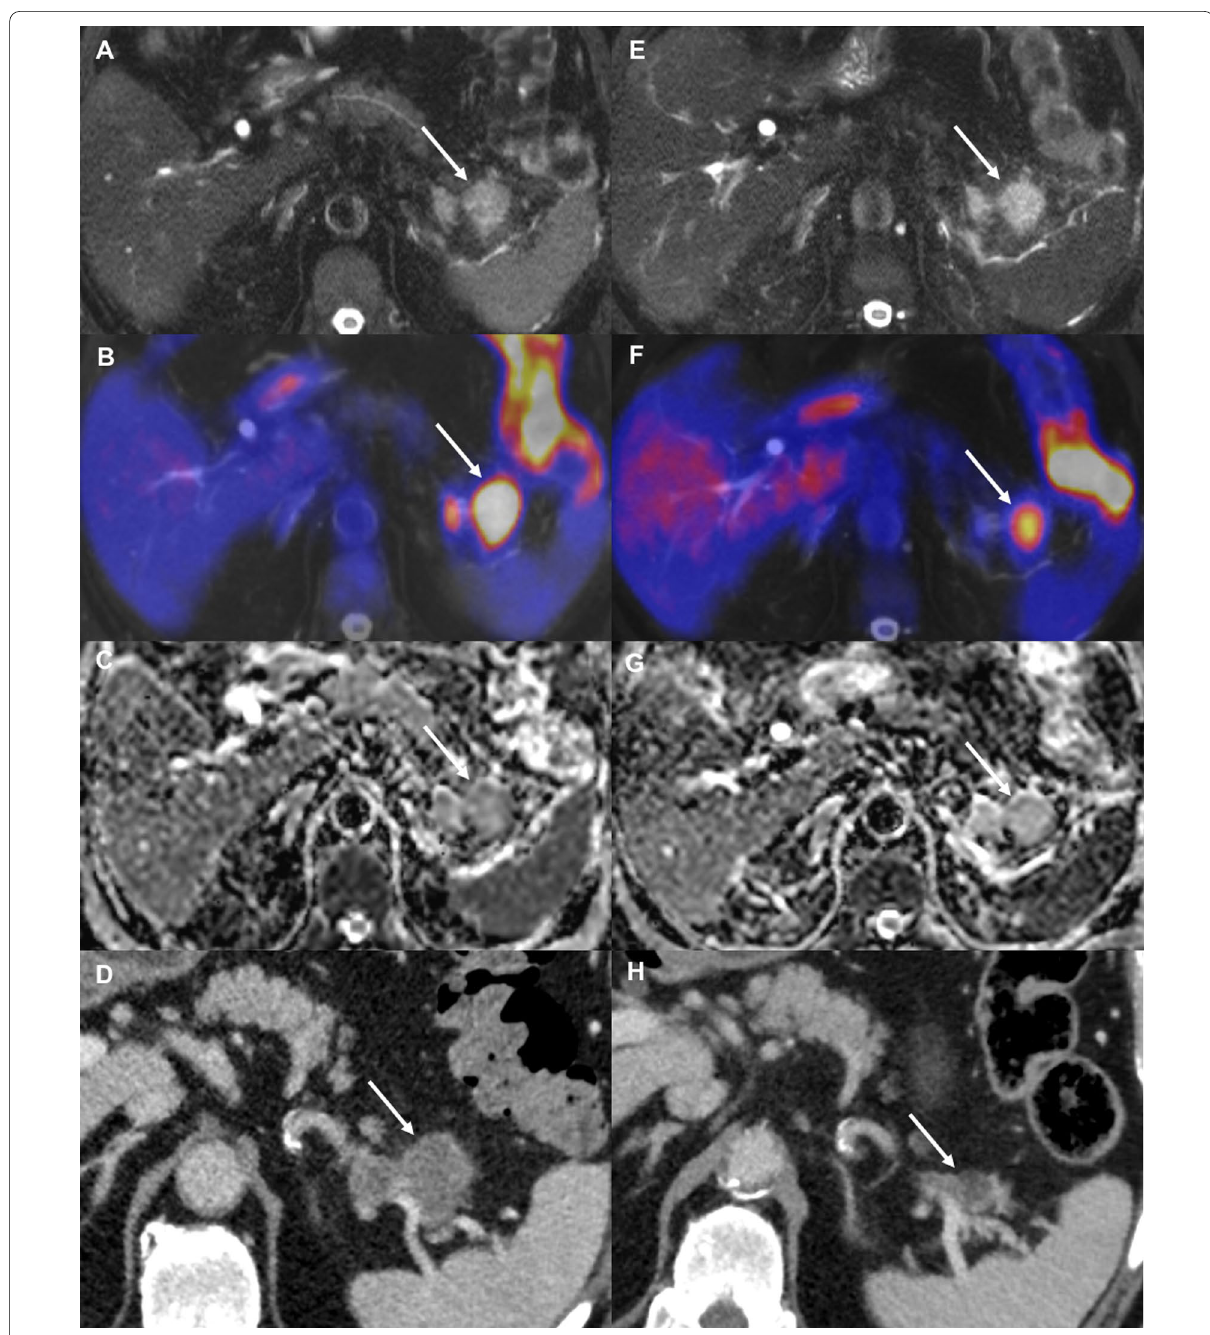
Fig. 4 Images from a 69y-old male patient with a PDAC in the pancreatic tale. Images on the left ( a – d ) were obtained prior to the onset of chemotherapy, images on the right ( e – h ) were obtained 14 days later, after two cycles of neoadjuvant chemotherapy with nab-Paclitaxel/ gemcitabine. Axial T2 FS ( a , e ) show no change in tumor size. However, PET showed a significant decrease in MTV 50% (56.4%) and TLG 50% (53.9%) ( b , f ). Furthermore, a significant increase in ADC mean (44.8%) was seen ( c , g ). The bottom row displays the baseline CT ( d ) as well as the follow-up CT ( h ) after 5 cycles of nab-Paclitaxel/gemcitabine in the same patient. The follow-up CT was obtained after 81 days. Based on RECIST1.1 the patient was stratified as a responder. Left-sided pancreatic resection with splenectomy was performed after the follow-up